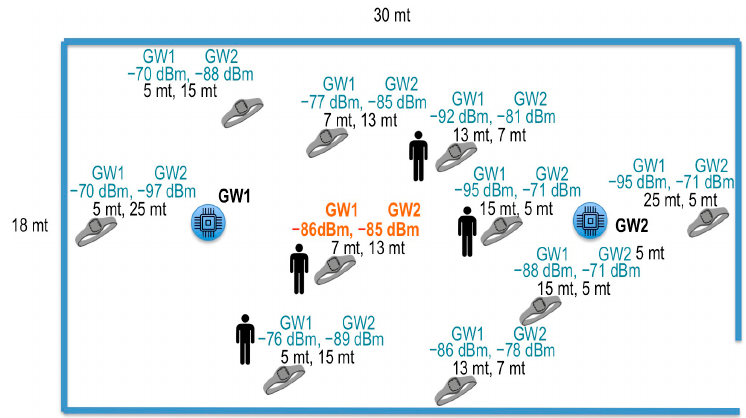
Figure 15. Two BLE gateways covering a large hall. The values in orange color highlight uncertainty.